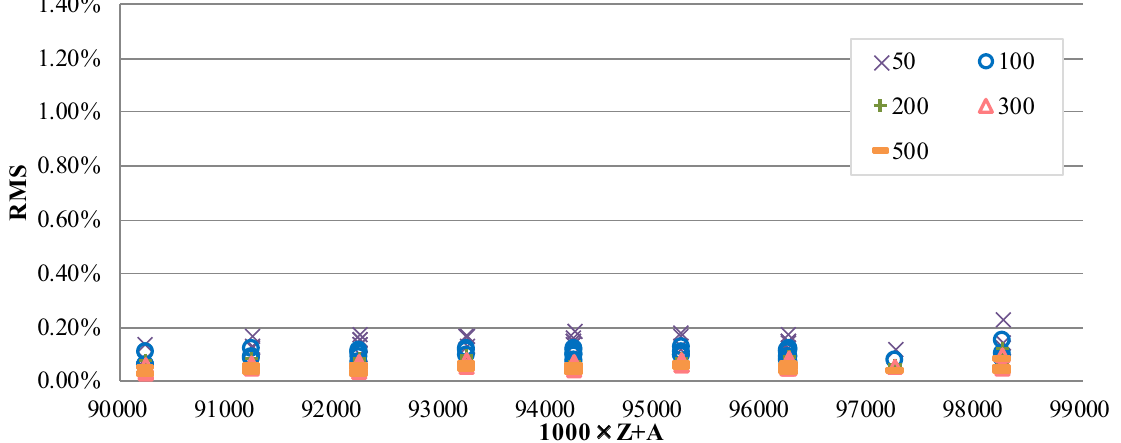
Figure 4. RMS values of probability table difference in each ladder number (fission).